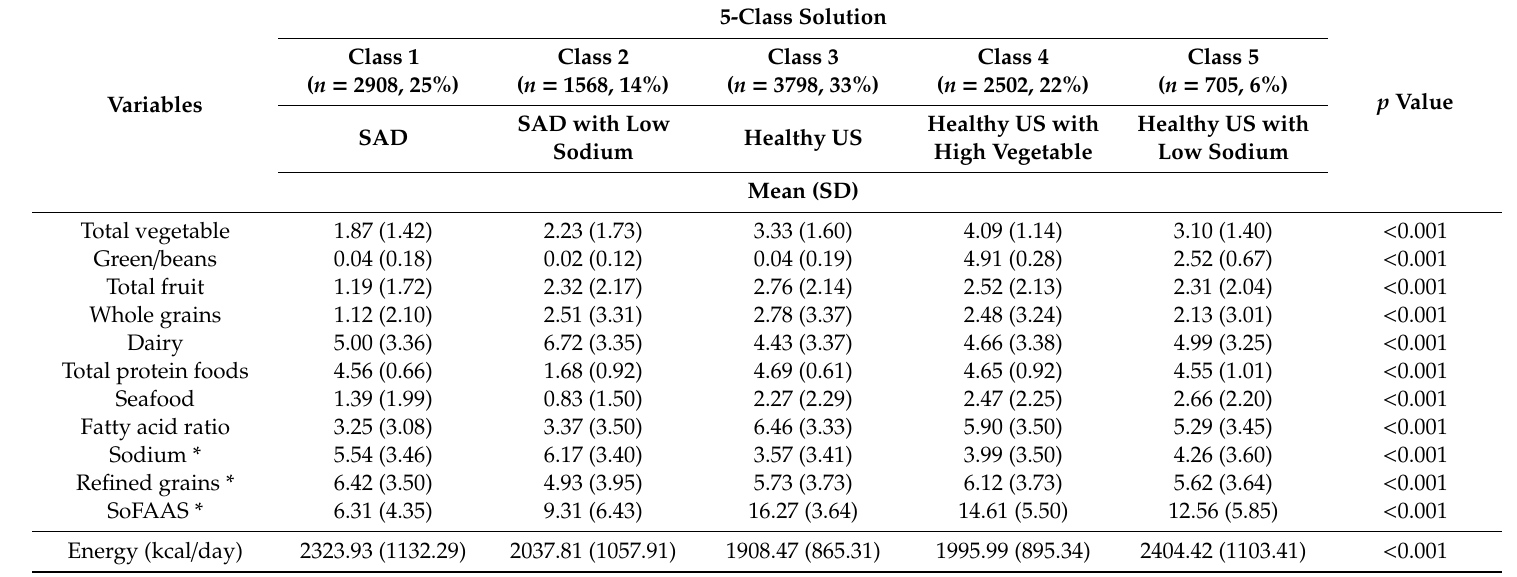
Table 5. Di ff erences in daily HEI-2010 components and energy (kcal / day) among the latent classes of the NHANES 2007–2010 population (age ≥ 19 years, N =